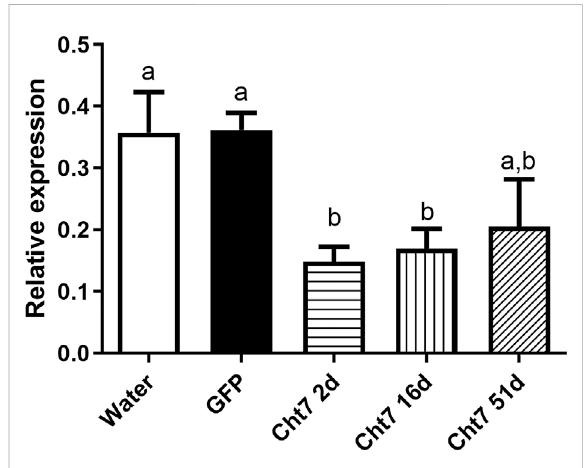
FIGURE 7 Persistence of silencing of RpCht7 chitinase gene evaluated by RT-PCR. Fifth-instar nymphs of R. prolixus were injected into hemolymph with water or GFP dsRNA as control and 1 µg for RpCht7 dsRNA and assessed in 2, 16, and 51 days after injection. Relative expression using Actin as constitutive reference gene, obtained with the ImageJ program (by band densitometry). Values marked with a or b correspond to signi fi cantly different groups ( p < 0.05; T-test), N = 3.